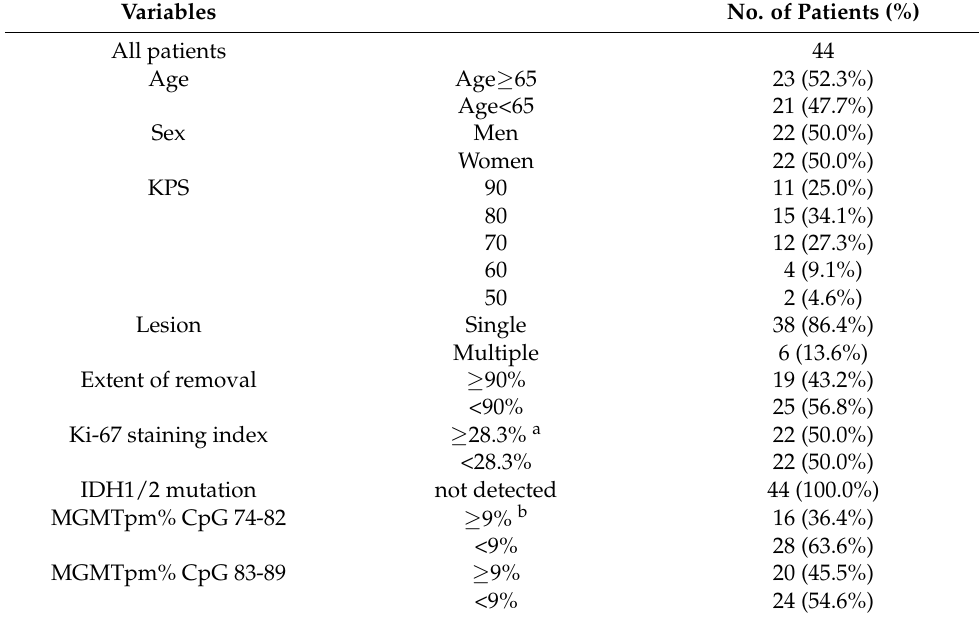
Table 1. Baseline patient characteristics.